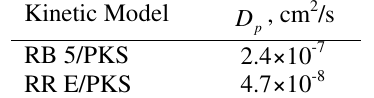
Table 4. Values of D for adsorption of RB 5 and RR E onto PKS based-AC. p